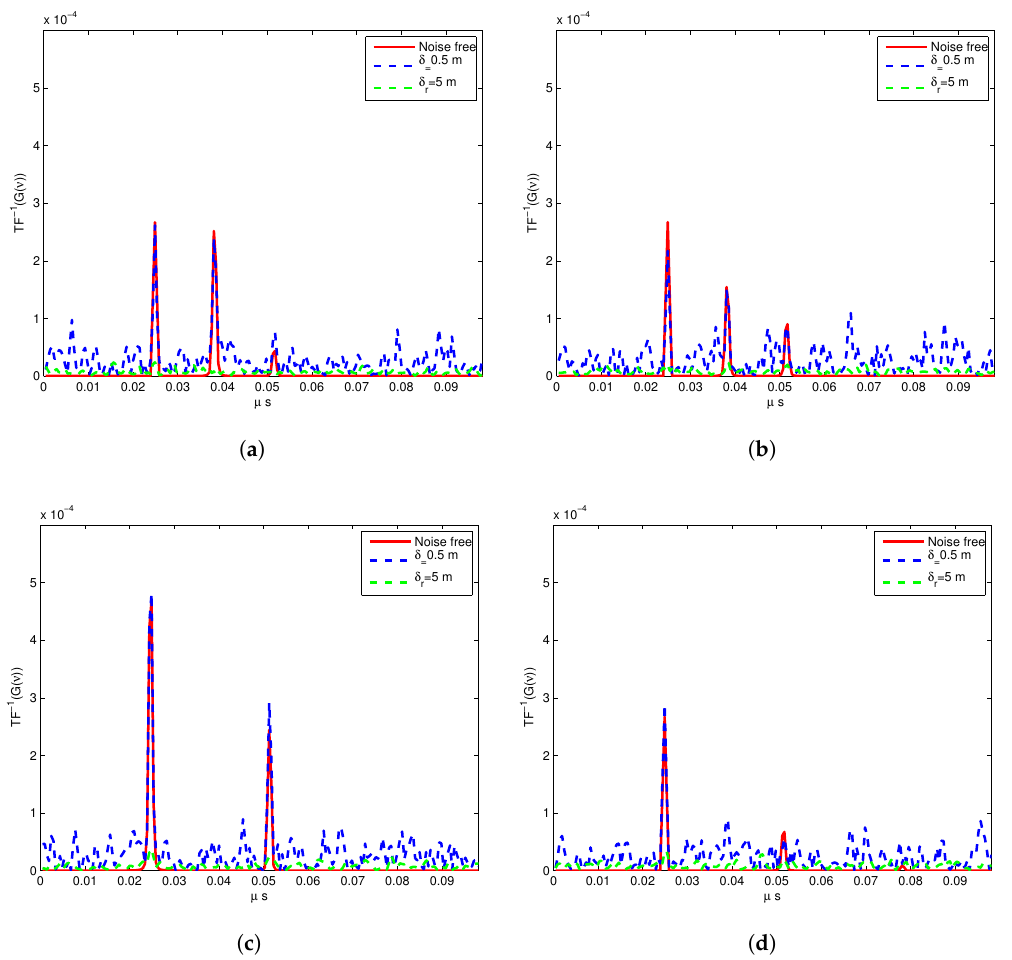
Figure 7. Example of inverse Fourier transform of G ( ν ) for f c = 0.1 GHz, d = 3000 m, h r = 300 m for h S = 3 m, HH ( a ) and VV ( b ) and h S = 20 m HH ( c ) and VV ( d